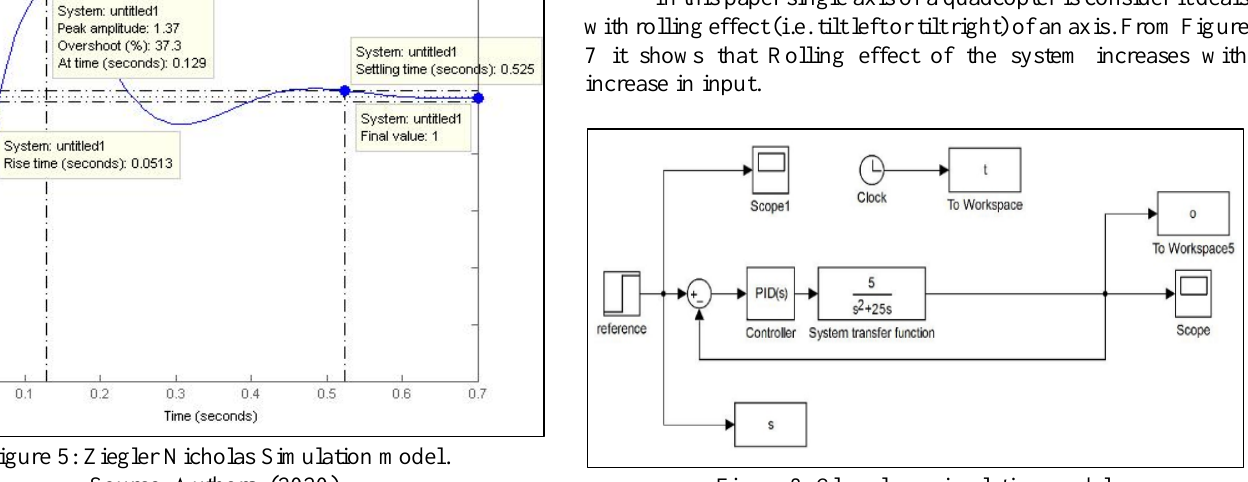
Figure 8: Close loop simulation model.